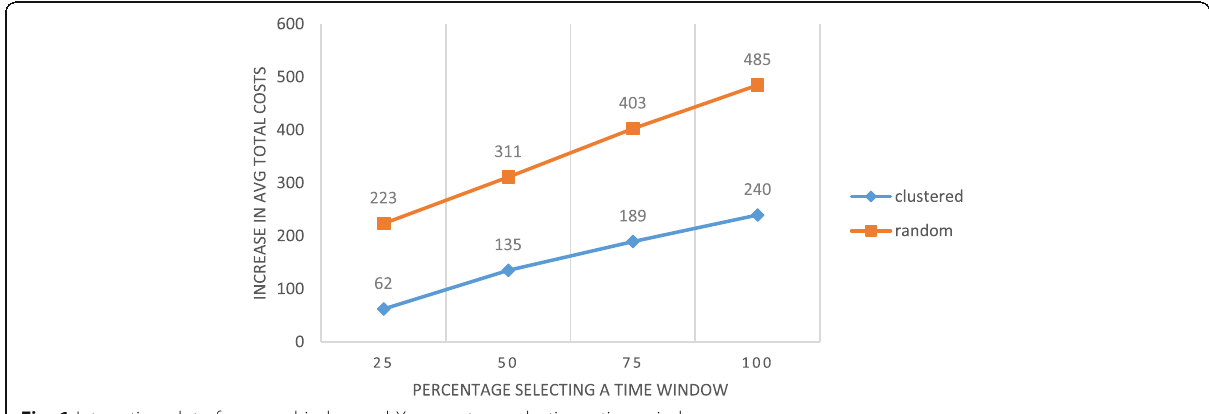
Fig. 1 Interaction plot of geographical spread X percentage selecting a time